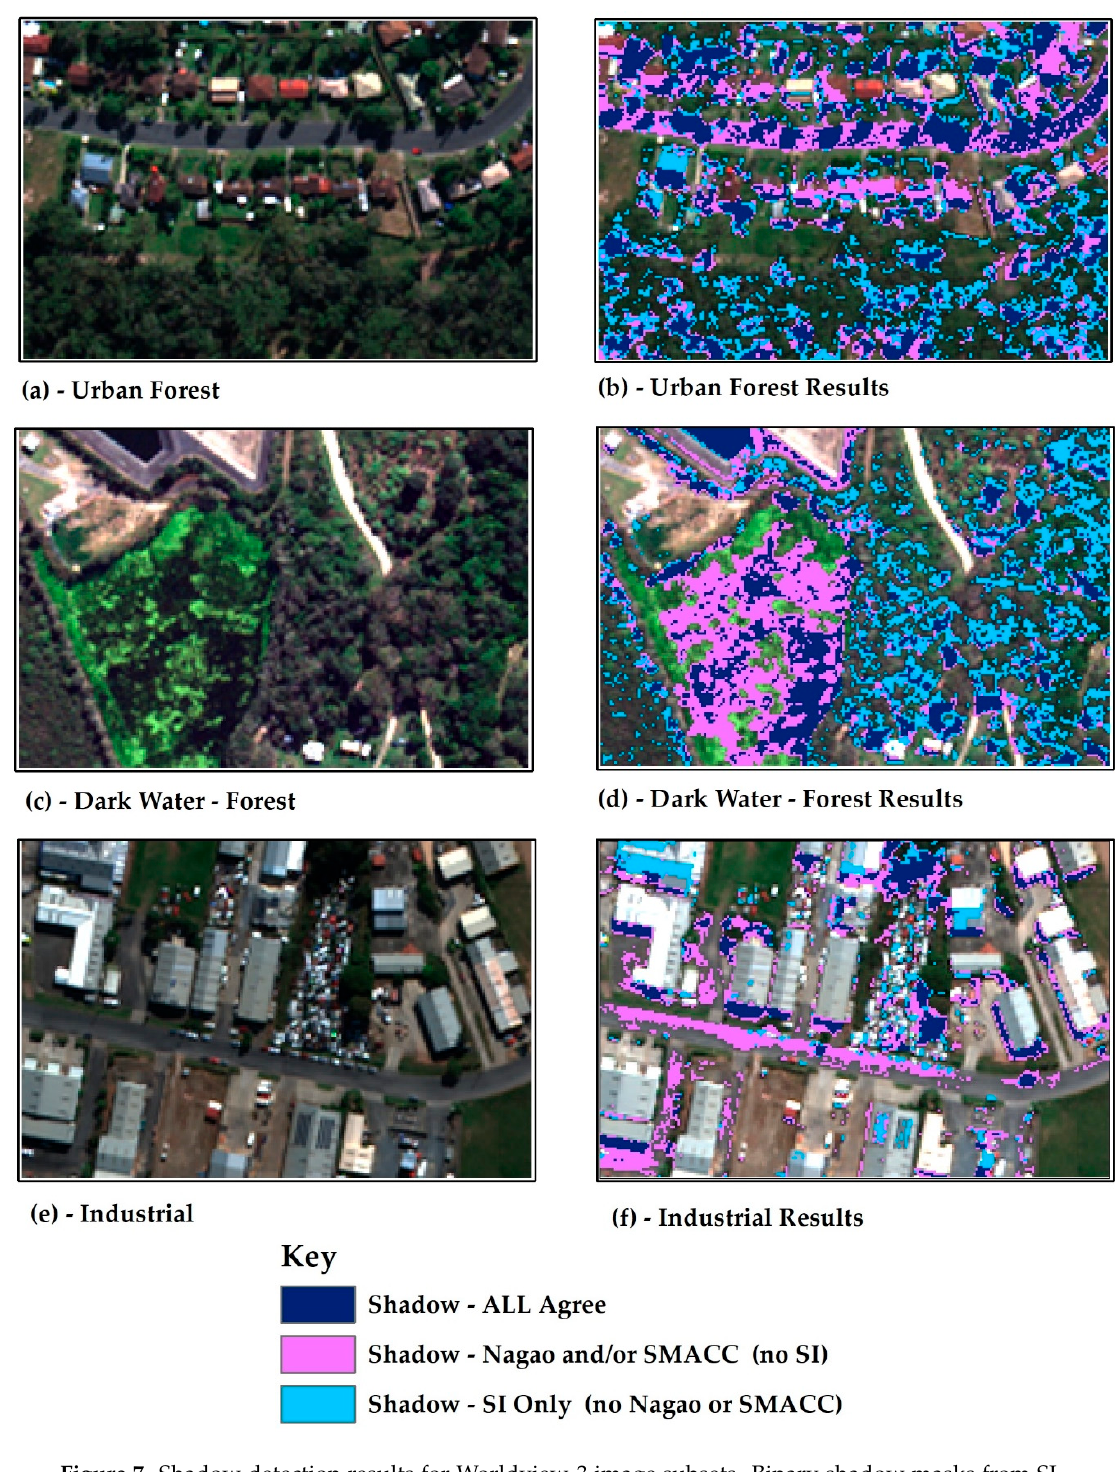
Figure 7. Shadow detection results for Worldview-3 image subsets. Binary shadow masks from SI, Nagao and SMACC methods are combined into three display classes. Subsets ( a , c , e ) are original images and subsets ( b , d , f ) are respective shadow detection results.